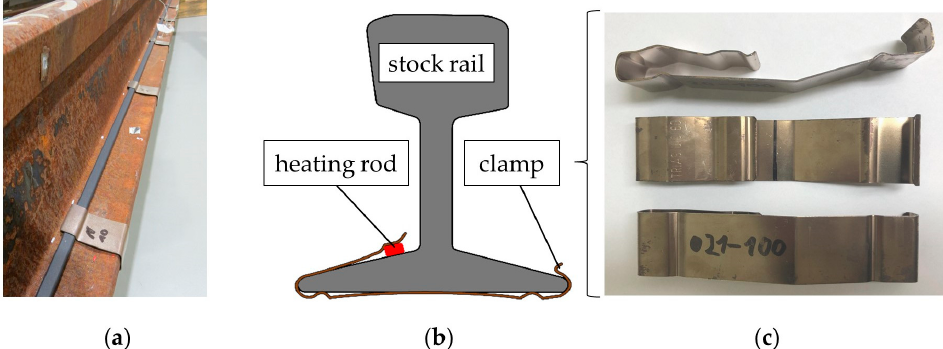
Figure 4. ( a ) Attachment of the heating rod by clamps; ( b ) schematic view of a heating rod, stock rail, and clamp; ( c ) shape of a relaxed clamp.